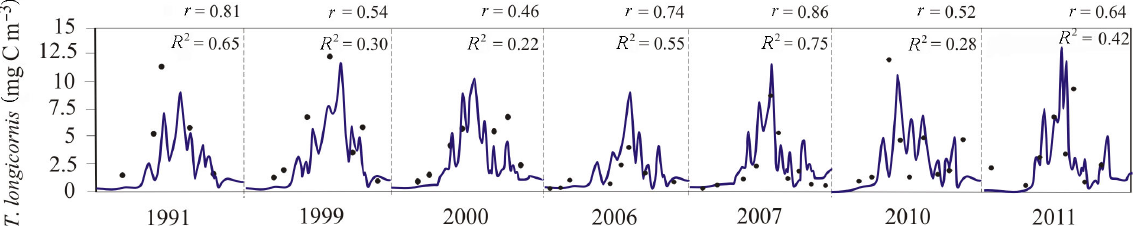
Fig. 3. The temporal distribution of the observed (circle) and modelled (line) total biomass for Temora longicornis as averages in the water column and Pearson’s linear correlation coefficients r and coefficient of determination R 2 . Data 1991, 1999, 2000, 2006 and 2007 were used for model calibration, data 2010 and 2011 for model